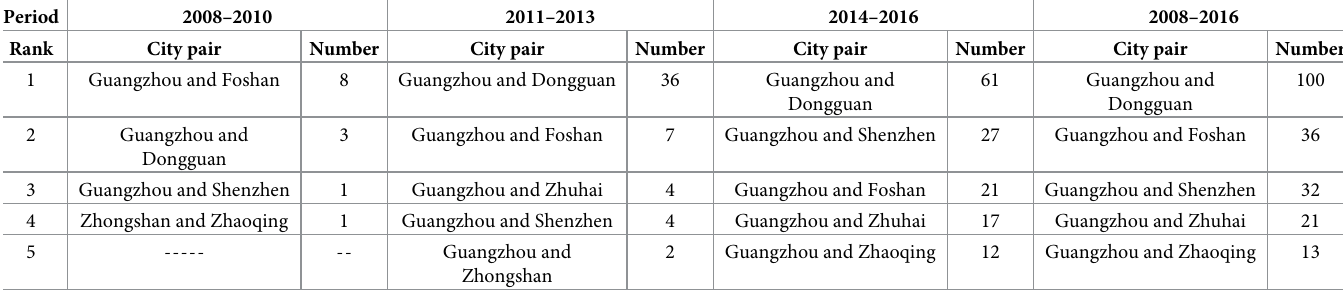
Table 13. Top 5 cities, cross-city cooperation, based on common patent data of the Pearl River Delta Urban agglomeration, 2008–2016.